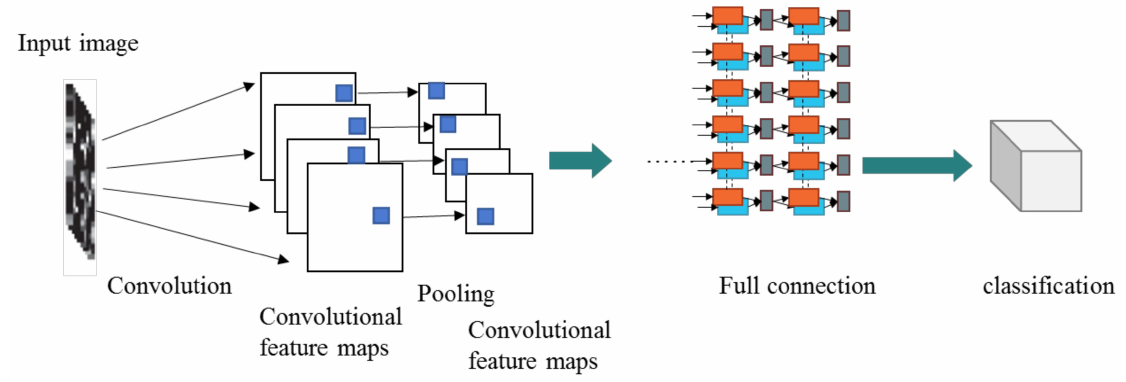
Figure 1. Typical convolution neural network